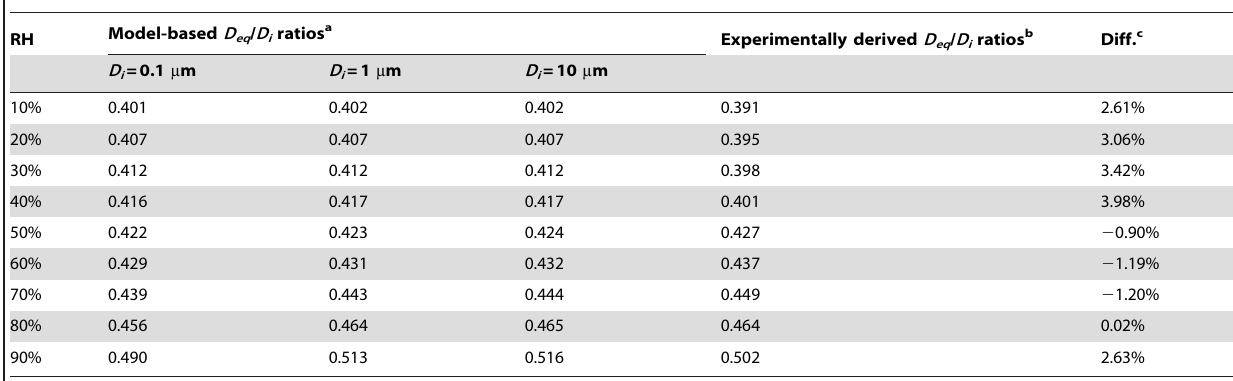
a Calculated according to the SS-VA model of Mikhailov et al. [23]. b Calculated based on volume additivity using experimental data from Tang et al. [25] and Bagger et al. [26]. c Difference between modeled and experimental D eq / D i ratios for D i =10 m m.